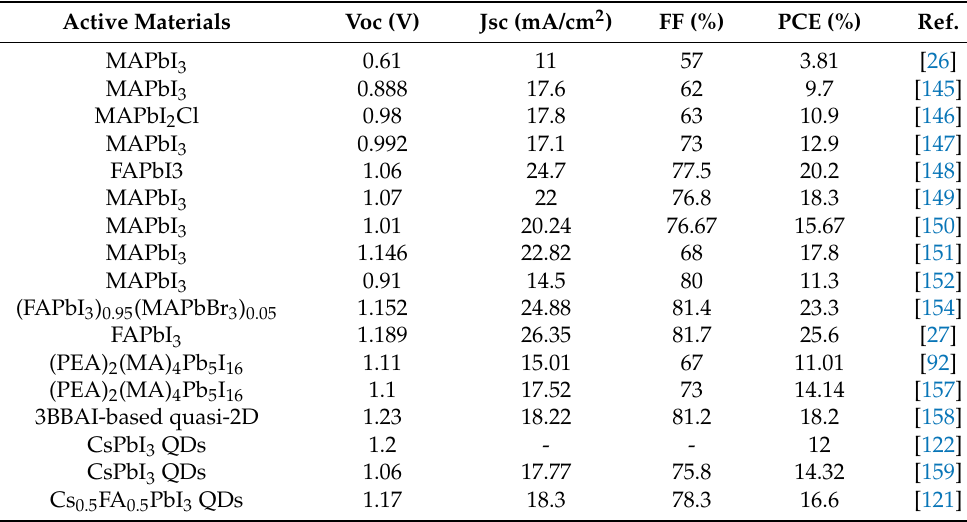
Table 3. Summarized device performance for solar cells in Section